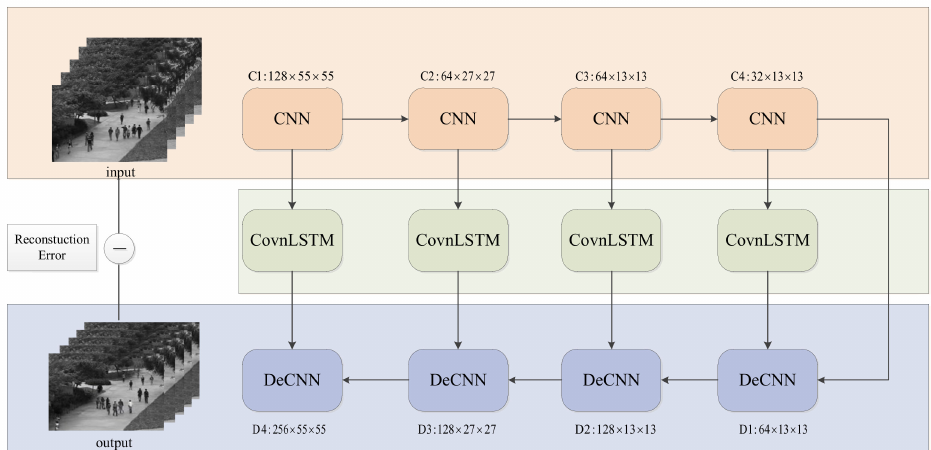
Figure 4. Overall architecture of the proposed CR-AE